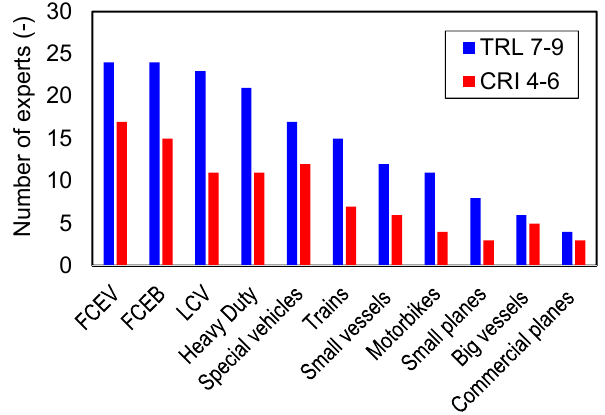
Figure 2. Assessment of the TRL and CRI levels for hydrogen technologies in transport solutions [11] (TRL 7–9 indicates the number of experts who determined a given technology/application to qualify as TRL 7, TRL 8 or TRL 9 in the TRL classification; CRI 4–6 indicates the number of experts who determined a given technology/application to qualify as CRI 4, CRI 5 or CRI 6 in the CRI classification); FCEV—fuel cell electric vehicle, FCEB—fuel cell electric bus, LCV—light commer- cial vehicle.